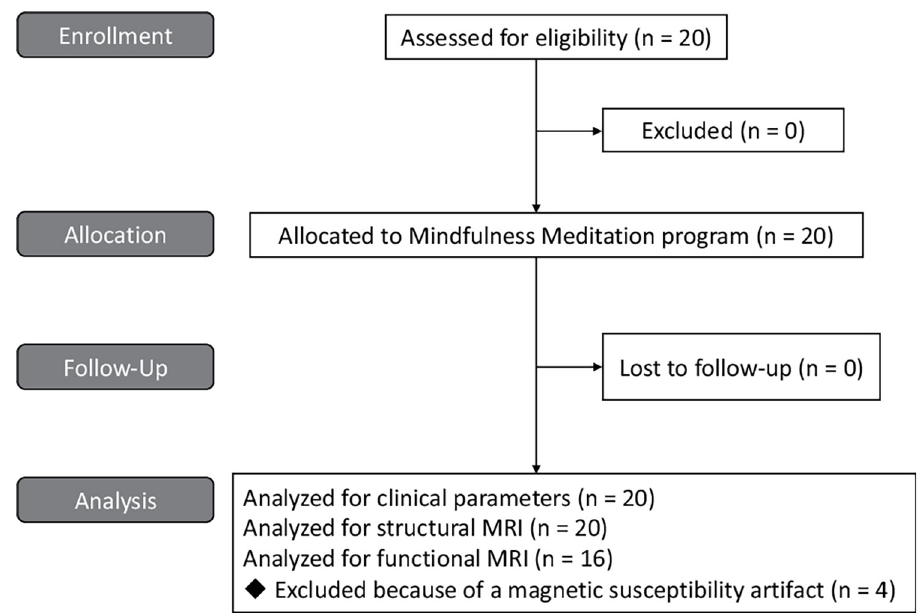
Fig 1. Flow diagram illustrating participant enrollment, allocation, and